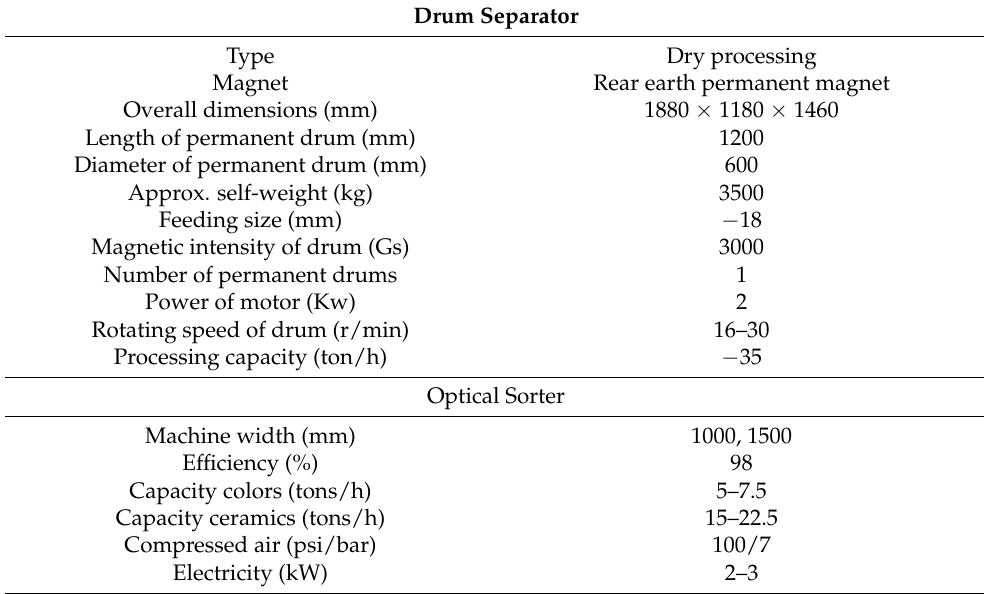
Table 3. Specifications for drum separator and optical sorting machines. Drum Separator Type Dry processing Magnet Rear earth permanent